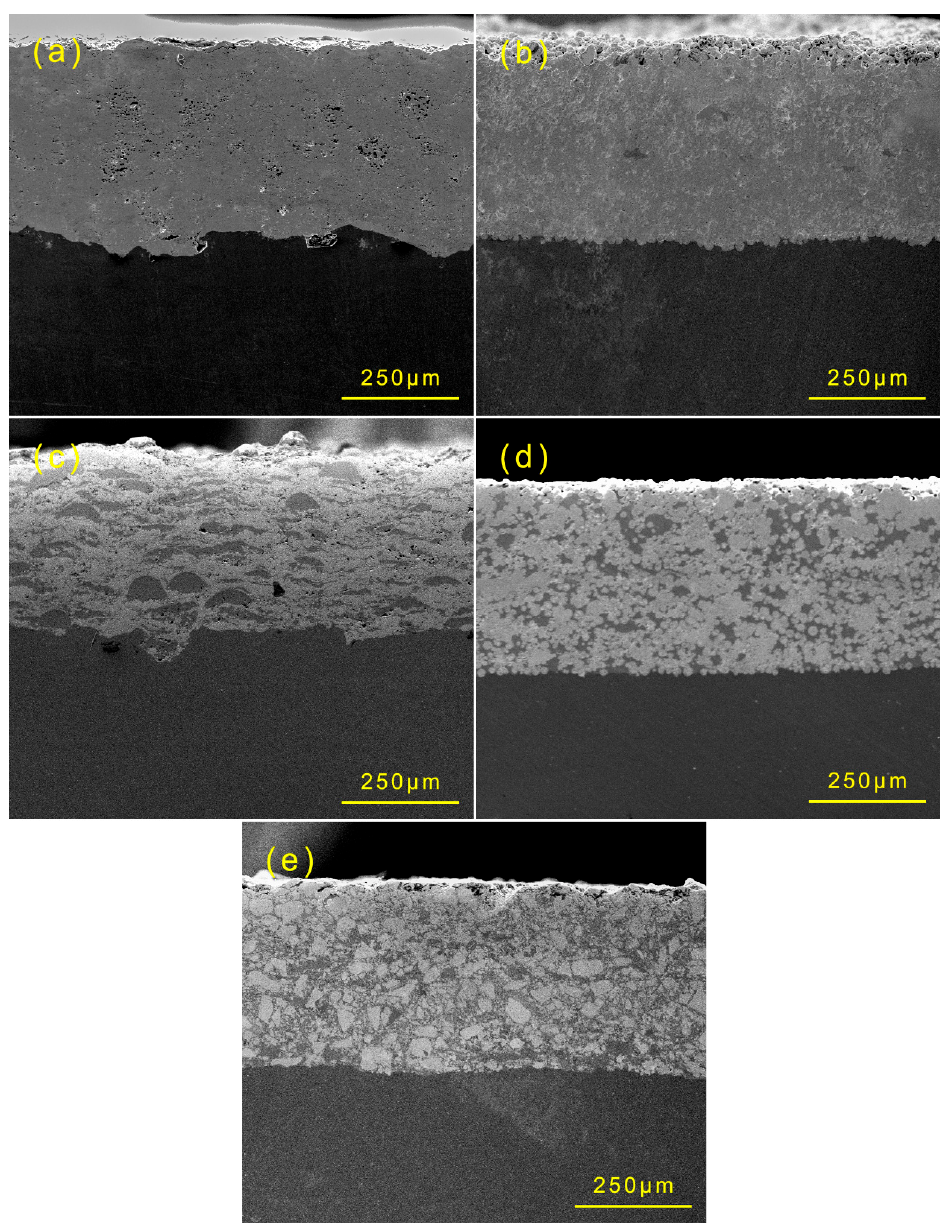
Figure 6. Cross-sectional microstructure: ( a ) H1; ( b ) E1; ( c ) H2; ( d ) E2; ( e ) E3. When the bonding phase proportion was high enough, the internal porosity of the coatings was greatly reduced. In addition, the internal structure of the E2 coating was denser than that of the H2 coating. Compared with the H1 coating, the uneven distribu- tion of hard phase and bonding phase was obvious in the H2 coating. Most of the ag- glomerated WC-Co spherical particles were not able to retain their original spherical shape. These particles experienced significant fracture deformation during flight impact and finally exhibited an irregular shape [23]. The distribution of hard phase and bonding phase in the E2 coating was relatively uniform, and the porosity was lower. In particular, compared with E1 coating, it could be clearly seen that the spherical geometry of